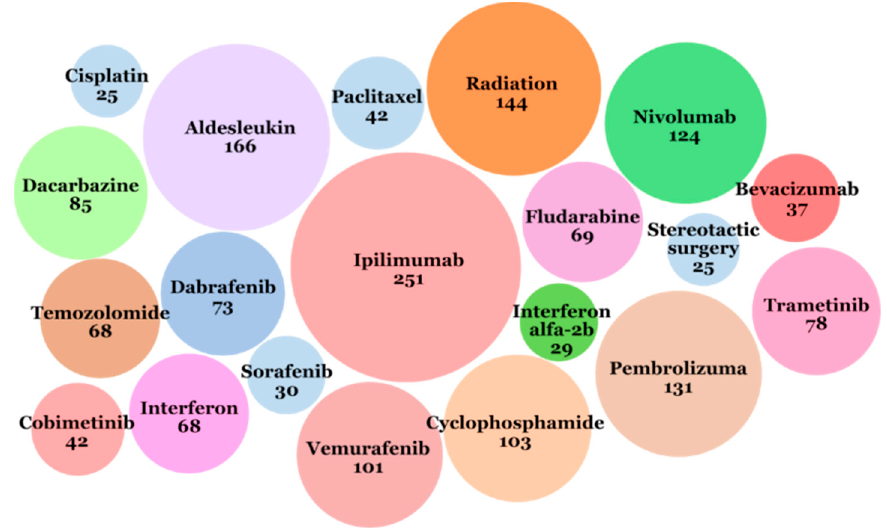
Figure 6. Twenty interventions that most often appeared in the ICTRP database from 1971 to 2018. The number under the name of intervention means the number of clinical trials in which the intervention was applied.